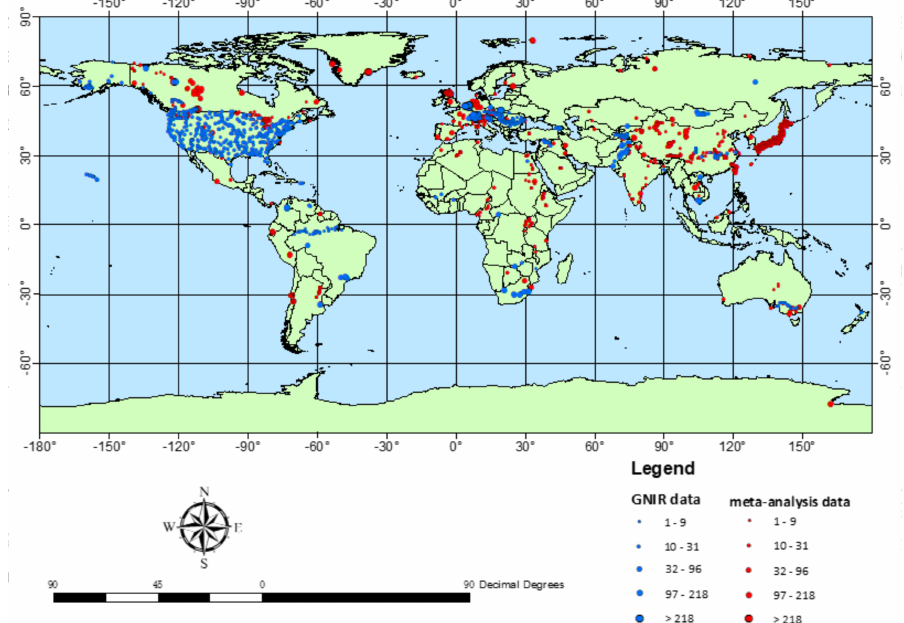
Figure 2. Location of GNIR data and meta-analysis data. Original GNIR data and meta-analysis are presented as blue points and red points, respectively. Sizes of the points represent amount of